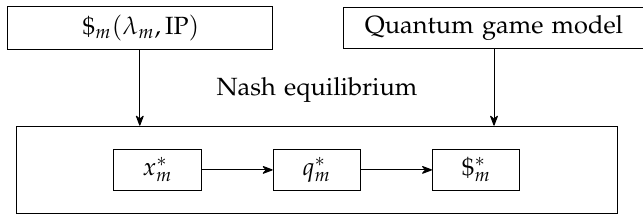
Figure 1. Model construction.